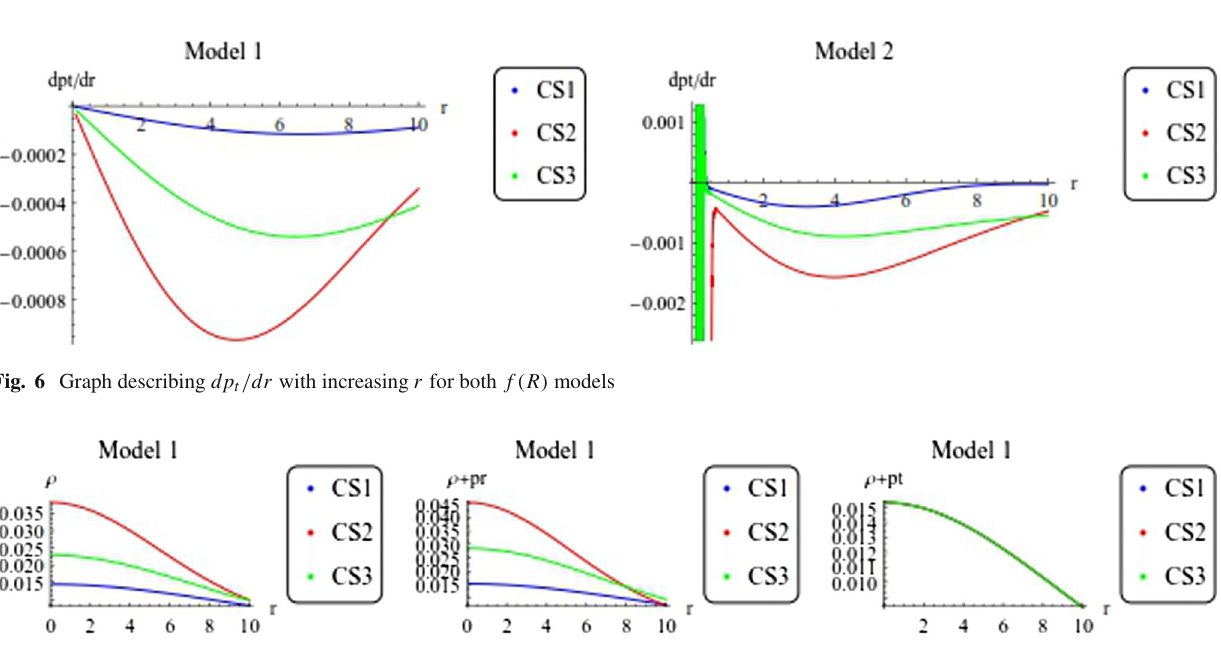
Fig. 5 Graph describing dp r / dr with increasing r for both f ( R ) models